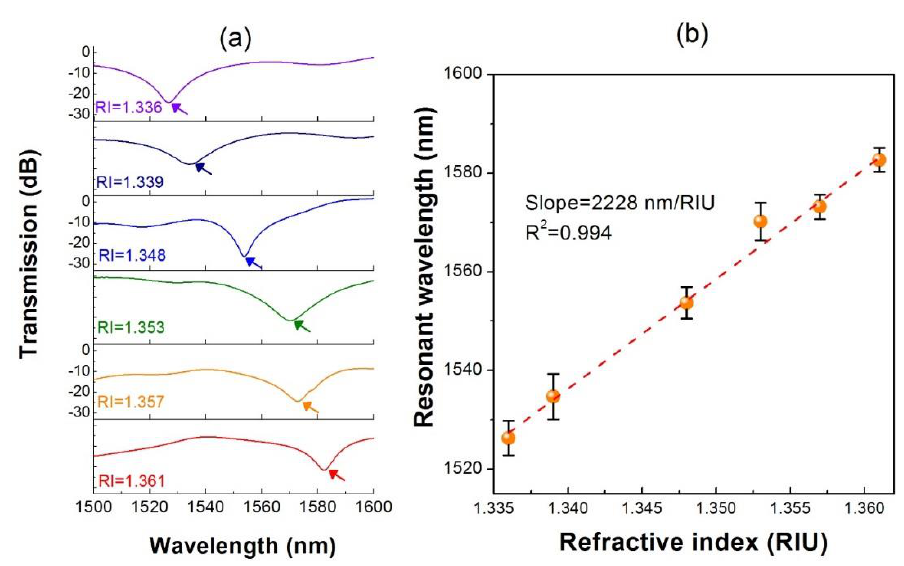
Figure 2. ( a ) Spectral change of the VIOLIN with respect to the RI increase of the liquid. ( b ) Response curve between the resonance wavelength and the liquid RI. Error bars indicate the standard deviations of three independent measurements and below were the same.